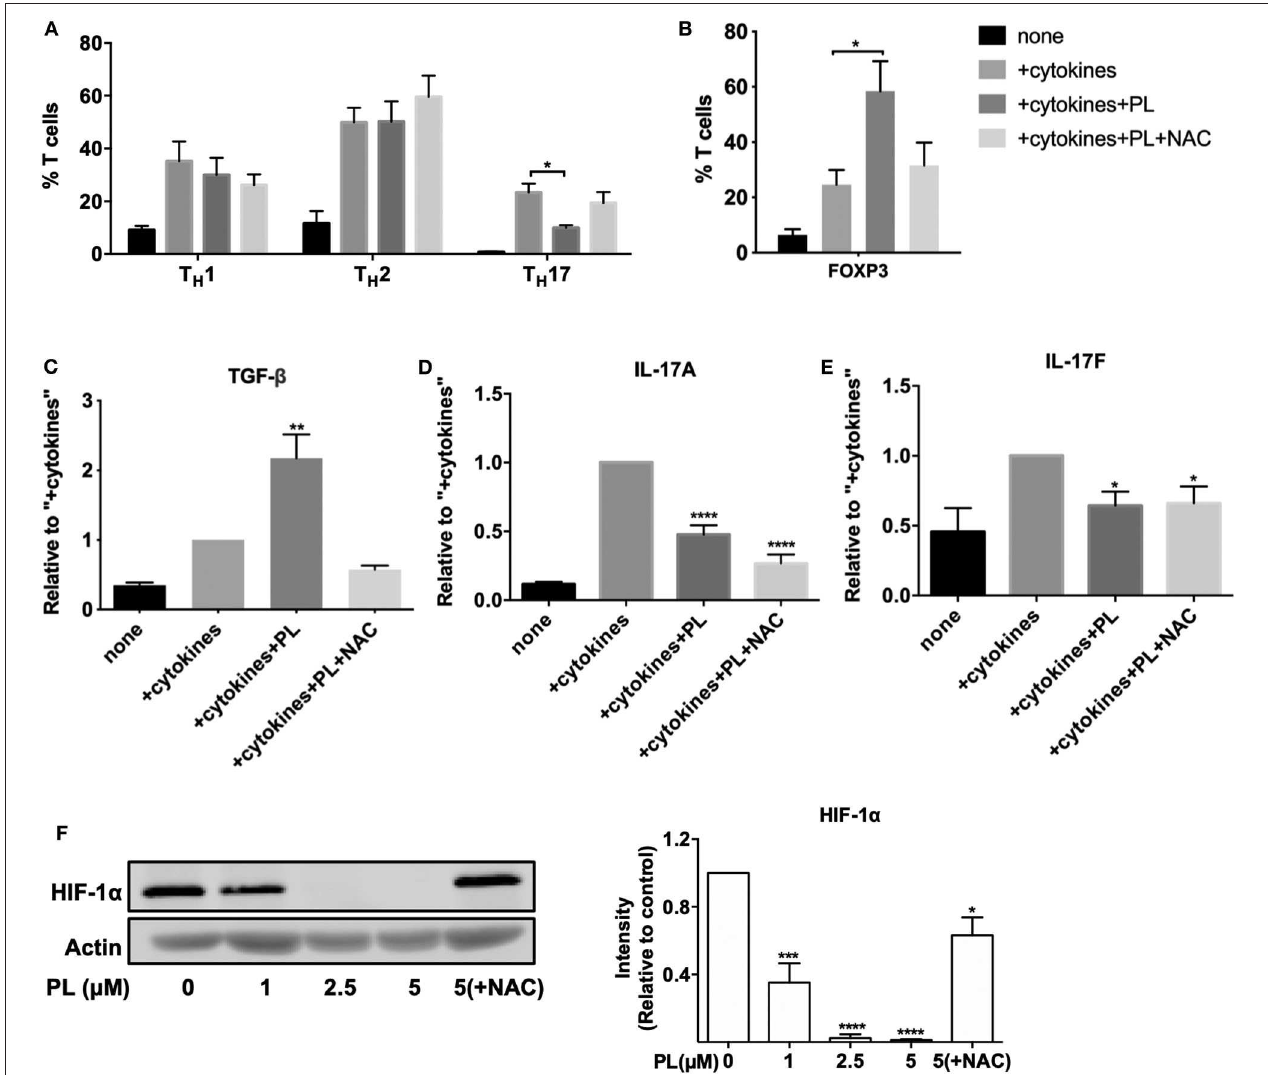
FIGURE 6 | PL inhibits the differentiation of naïve CD4 + T cells into T H 17 cells while promoting the development of T reg cells. (A–C) Naïve CD4 + T cells were costimulated by anti-CD3/CD28 antibodies either alone (none) or in the presence of T H 1, T H 17, or T H 2 polarizing cytokines without ( + cytokines) or with 1 µ M PL treatment ( + cytokines + PL), or with both PL and NAC treatment ( + cytokines + PL + NAC). (A) The differentiation of T H 1, T H 2, and T H 17 cells was assessed by surface staining of CD183, CD194, and CD196 and was analyzed by flow cytometry. Shown are the percentage of the respective T H subset in the total T cell population ( n = 5; mean; SEM; * p < 0.05). (B) T reg cells were identified by nuclear staining of FOXP3 ( n = 3; mean; SEM; * p < 0.05). (C) TGF- β levels after T reg polarizing differentiation conditions, (D) IL-17A and (E) IL-17F levels after T H 17 polarizing differentiation conditions were detected by ELISA ( n = 3; mean; SEM; * p < 0.05, ** p < 0.01, **** p < 0.0001). (F) HIF-1 α was detected by western blot (left). T cells were pretreated with or without PL and NAC as indicated for 30min and seeded into anti-CD3/CD28-coated plates for 24h. Cell lysates were loaded on SDS-PAGE gel and immunoblotted for HIF-1 α and actin. The expression levels